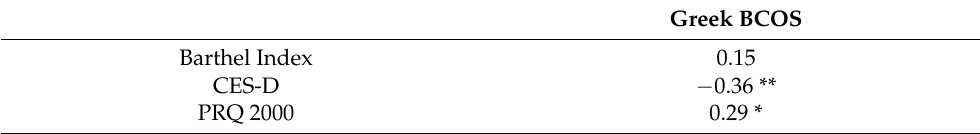
Table 4. Pearson’s correlation coefficients between Greek BCOS Barthel Index, CES-D, and PRQ 2000.